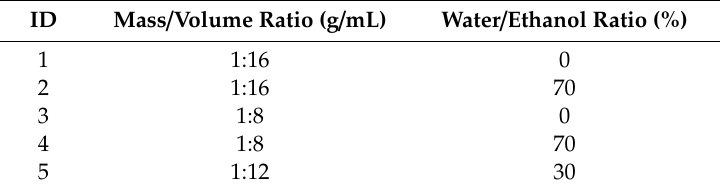
Table 1. Extraction condition of polyphenolic compounds in RP.